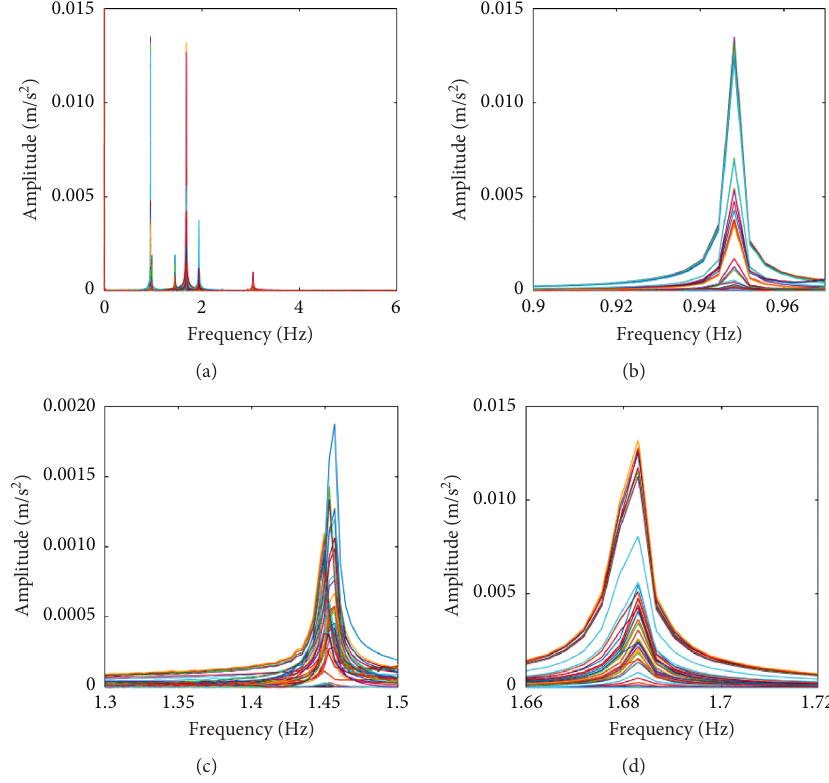
Figure 6: Frequency spectrum of the bridge: (a) overall view and (b–d) enlarged view.